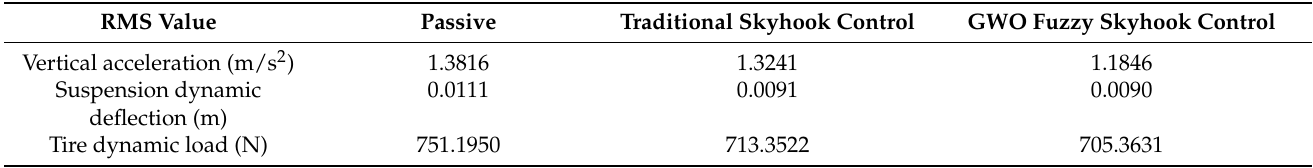
Figure 15. Road excitation of the C Class road profile. and the GWO fuzzy skyhook control are shown in Table 4 and Figures 16–18. Table 4. Body vertical root mean square (RMS) acceleration, suspension dynamic deflection, and tire dynamic load under C class road excitation.